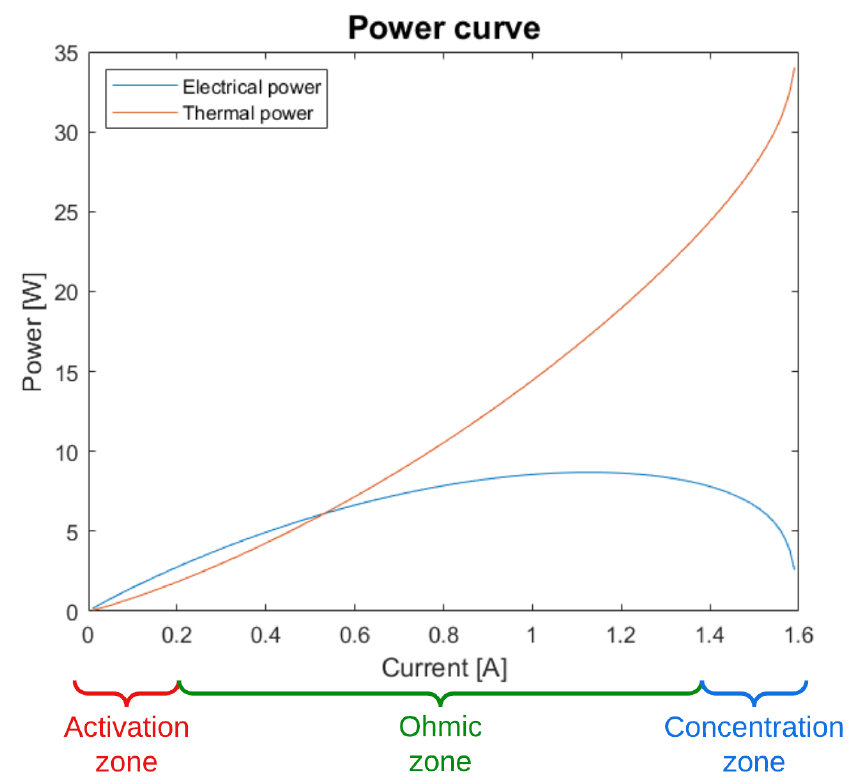
Figure 4. Electrical and thermal power curves of a HT-PEMFC (20 cells, area of 1 cm 2 and temperature of 127 ◦